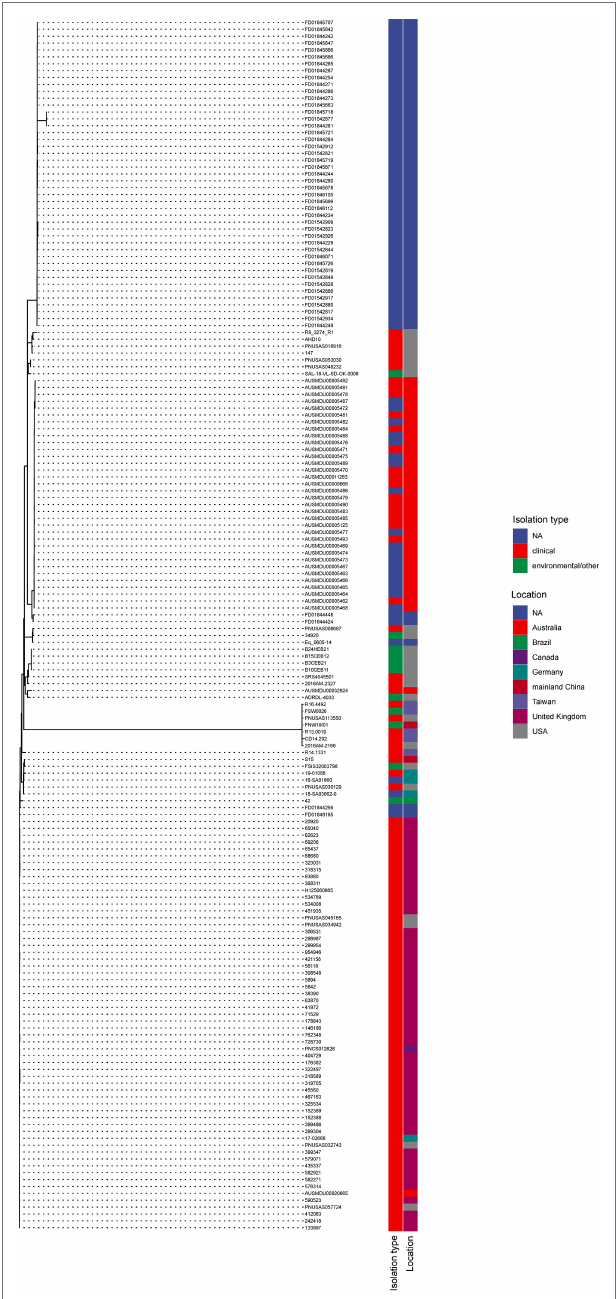
FIGURE 4 | The phylogenetic tree of mcr-9 carrying S. Typhimurium